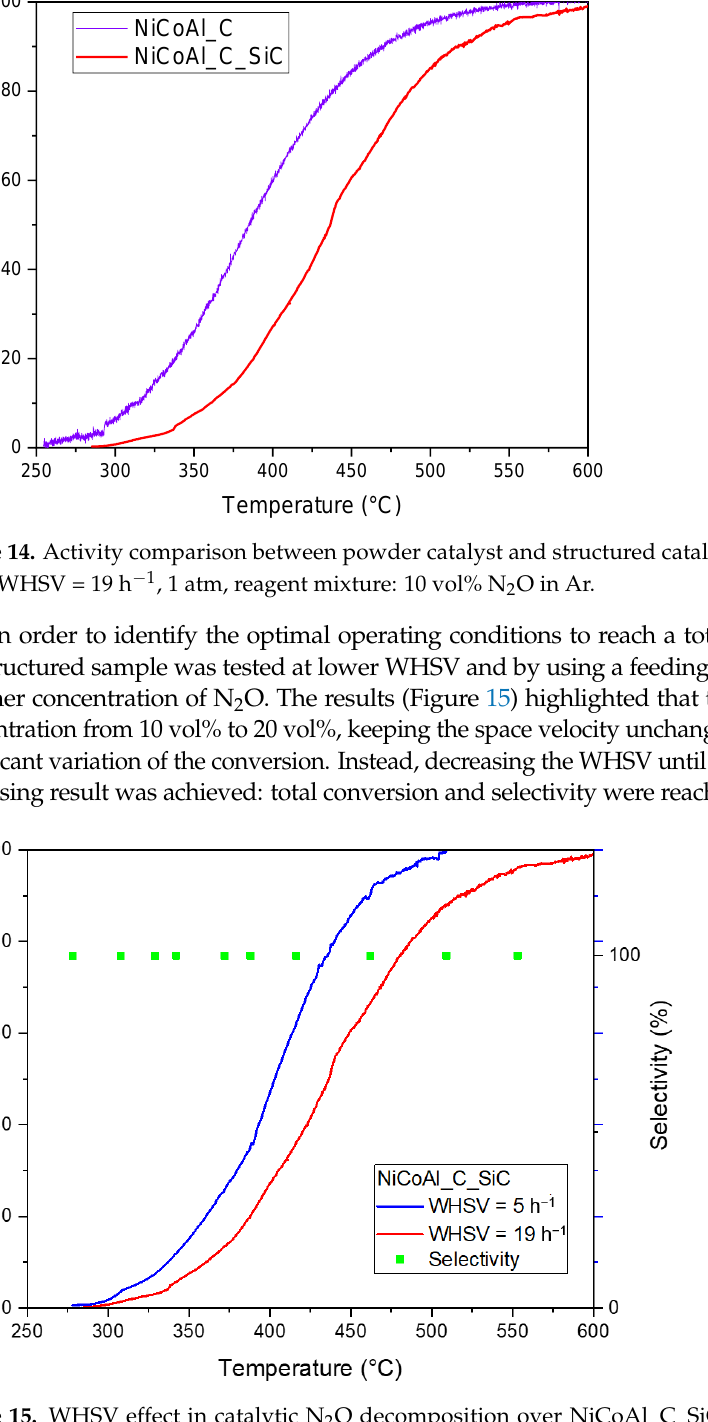
Figure 15. WHSV effect in catalytic N 2 O decomposition over NiCoAl_C_SiC structured catalyst (re- agent mixture: 20 vol% N 2 O in Ar, 1 atm). (reagent mixture: 20 vol% N 2 O in Ar, 1